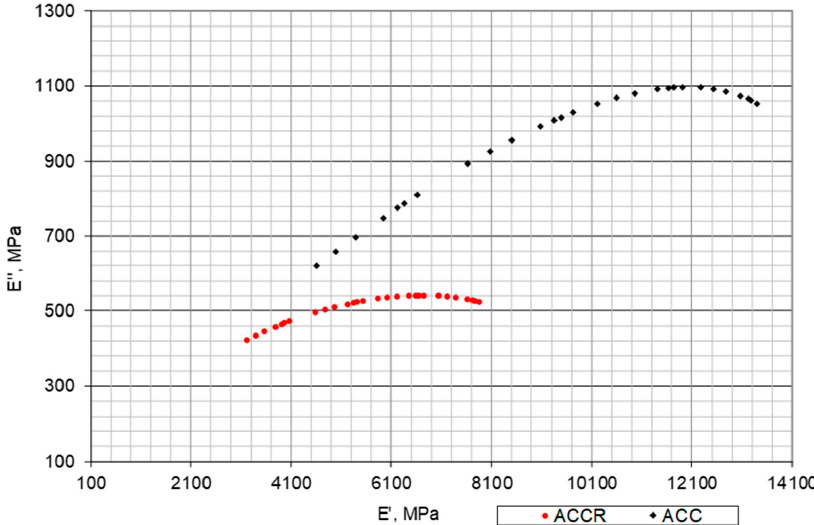
Figure 15. Cole-Cole plot of imaginary modulus E ″ vs. elastic modulus E ′ for ACC with 20% of “B” CR mortar and ACC with 20% cement-sand mortar (C:S = 1:1). The determined parameters for Equations (6) and (7) for the analyzed bituminous mixtures are given in Tables 4 and 5. The R 2 coefficient of determination indicates a very good relation between the values calculated and the results of the complex modulus tests. Table 4. Parameters of the stiffness modulus (E) master curve, Equations (5) and (6).